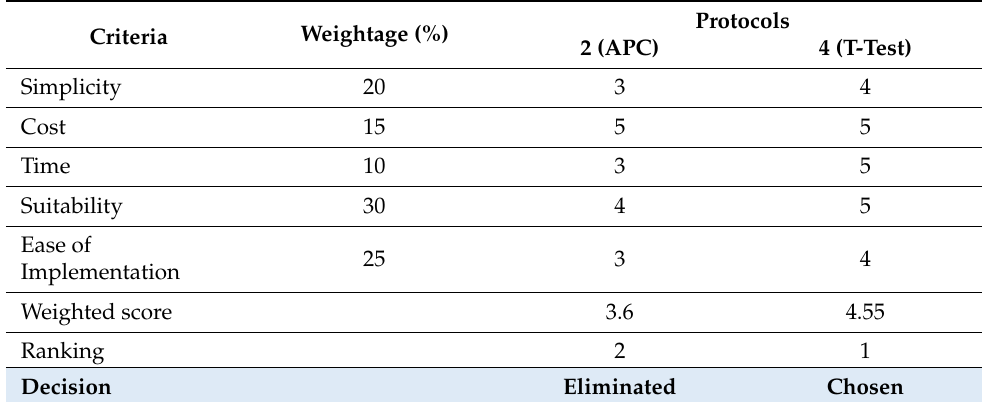
Table 12. Summary of the protocol scoring results of Protocols 1 and